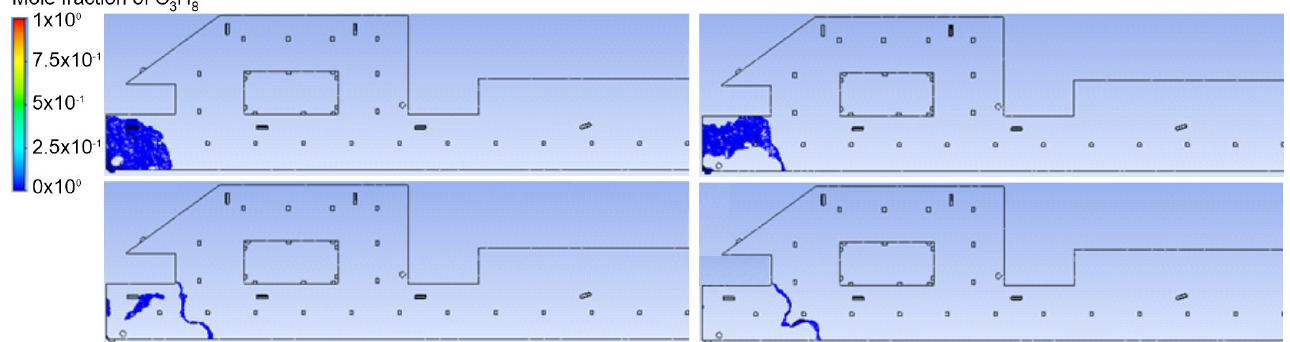
Figure 9. Trace amount of LPG near the end of dispersion for A source.